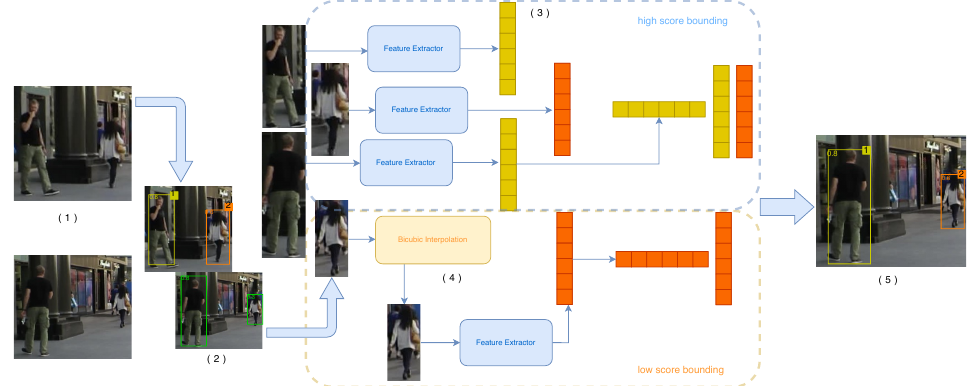
Figure 1. Workflow of our method: Given the video frame ( 1 ), the picture in the first line is the previous frame of the video, and the picture in the second line is the result of YOLOX detection. The tracking result of the previous frame and the image of this frame are predicted by the Kalman filter and matched with the detection result through IOU ( 2 ). For the high-scoring boxes in the detection boxes, after extracting its features, calculate the affinity with trajectories of the previous frame, and then match with each track ( 3 ); For boxes with lower scores, feature extraction is performed on the image after bicubic interpolation, and the affinity with the unmatched trajectories is calculated and then matched ( 4 ). Finally, the tracked result ( 5 ) is obtained.